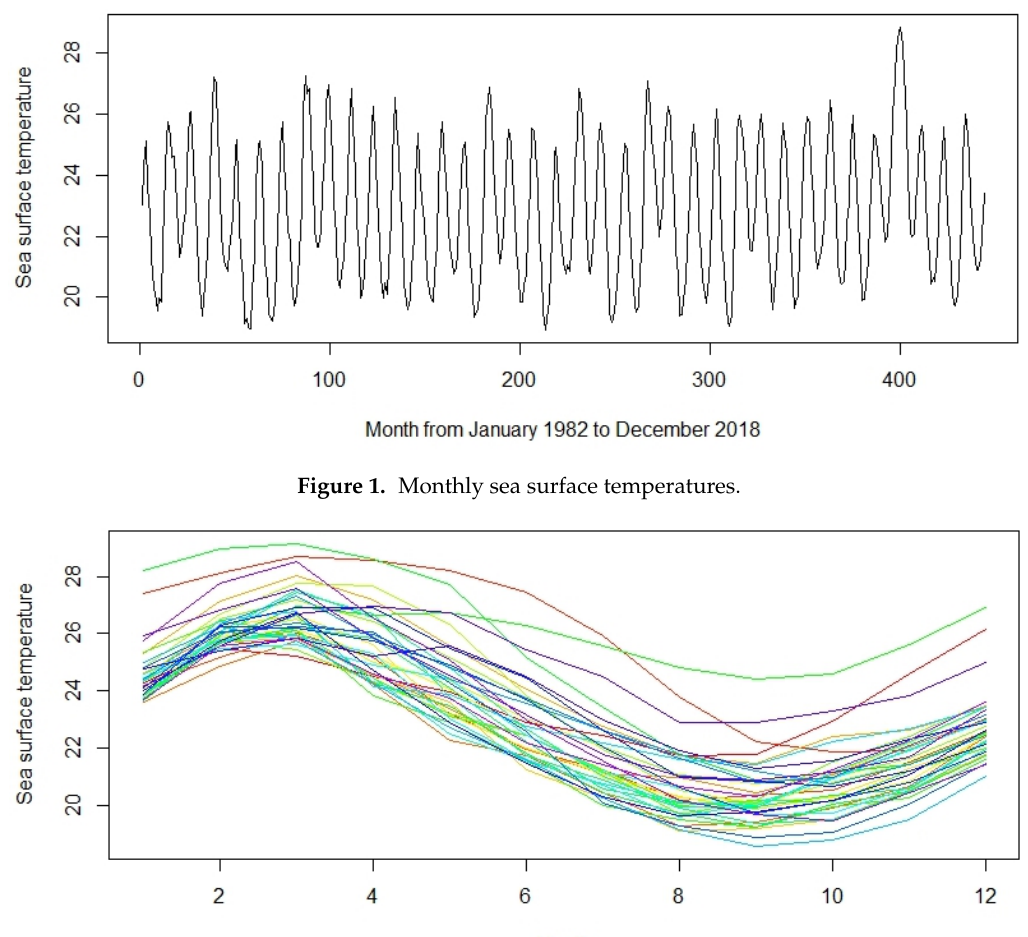
Figure 2. Monthly sea surface temperatures as functional observations by